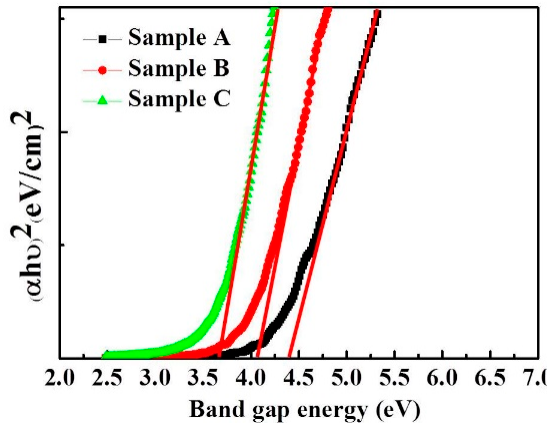
Figure 5. Tauc plots of the three samples with different target power values.